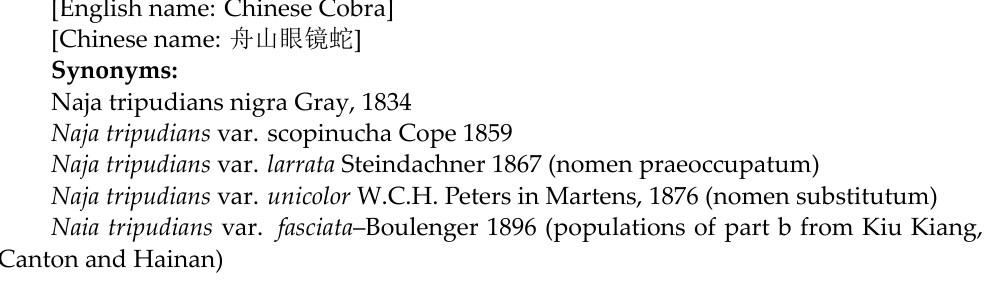
Figure 4. Body and head morphological comparisons between Naja atra ( A ), N. kaouthia South Asian clade ( B ), N. kaouthia Southeastern Asian clade ( C ) and N. fuxi sp. nov. ( D ). ( A ) subadult female (body length 730 mm) neotype of N. atra CIB12273 from Zhoushan Island, Zhejiang Province; ( B ) adult female N. kaouthia ZMH R04803 from Port Canning, West Bengal, India; ( C ) adult male ZMH R02885 of N. kaouthia from Bangkok, Thailand; ( D ) adult male holotype of N. fuxi sp. nov. CIB DL2018053147 from Panzhihua, Sichuan, China. 1: dorsal body; 2: ventral body; 3: dorsal head; 4: ventral head; 5: lateral head. ( A , D ) photographed by Sheng-Chao Shi; ( B , C ) by Gernot Vogel.